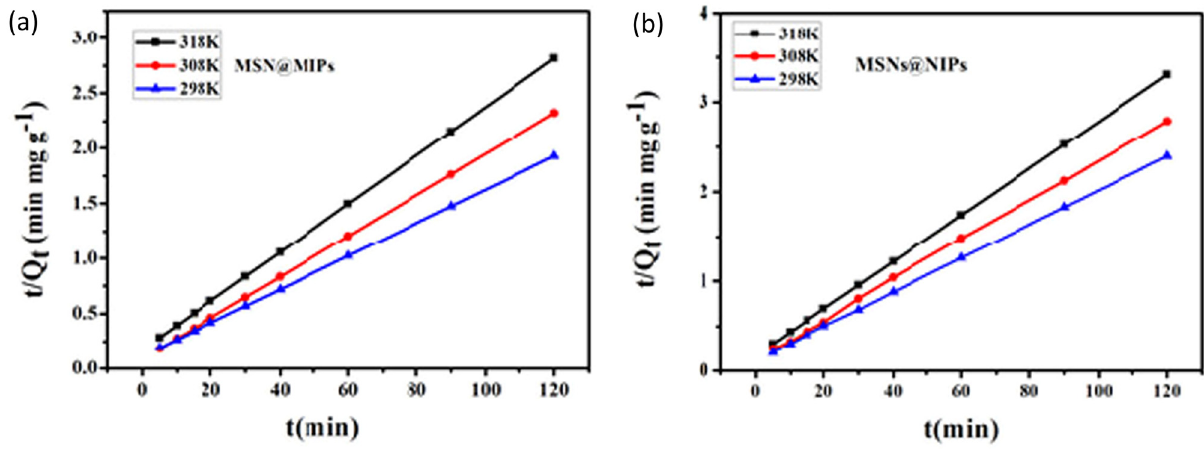
Figure 9: Pseudo - second - order kinetic equation fi t curve of ( a ) MSNs@MIPs and ( b ) MSNs@NIPs.